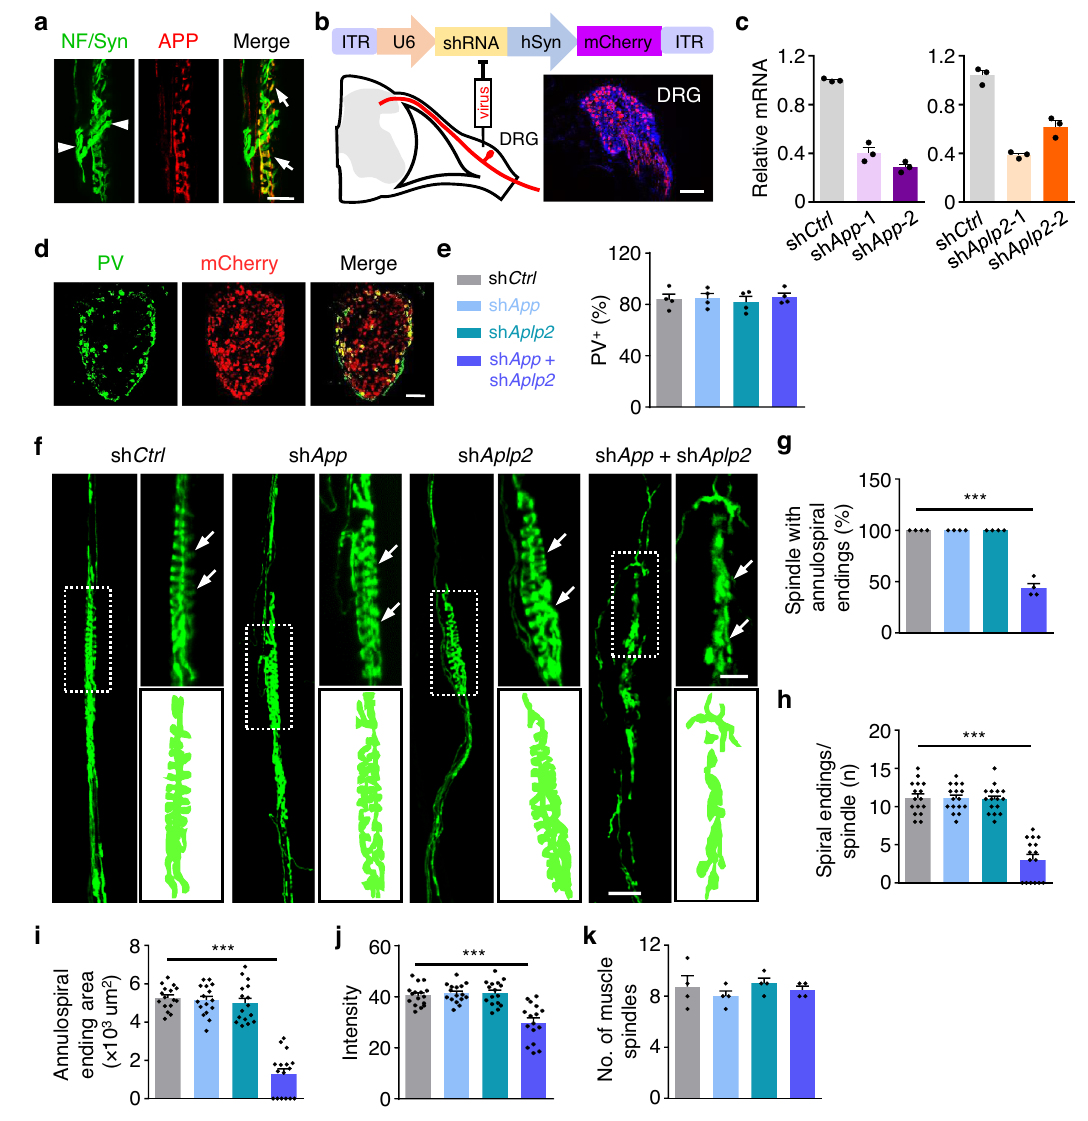
Fig. 6 | Degenerated annulospiral endings after App and Aplp2 knocked out. a EDL muscle of WT mouse waswholemount stained withNF/Syn(green) and APP (red).Arrows,APPandNF/Synpositiveannulospiralendings;Arrowheads,onlyNF/ Synpositiveaxons. Scalebar,20 µ m. b Construction and expressionof AAVshRNA in DRG (P60). Scale bar, 100 µ m. c Quantitative RT-PCR was performed to test the silence ef fi ciency of App shRNAs and Aplp2 shRNAs one month after the injection. sh App -1 and sh App -2 were reduced to 0.405±0.045 and 0.287±0.026, respec- tively. sh Aplp2 -1 and sh Aplp2 -2 were decreased to 0.387±0.016 and 0.62±0.048, respectively.Dataareshownasmean±SEM, n =3micepergroup. d Representative images of virus infected (red) DRG section stained with anti-PV (green). Scale bar, 100 µ m. e Quanti fi cation of the percentage of PV + neurons infected by mCherry- expressing virus. Data are shown as mean±SEM, n =4 mice per group. f RepresentativeimagesofmusclespindlelabeledbyNF/Syninsh Ctrl ,sh App alone,